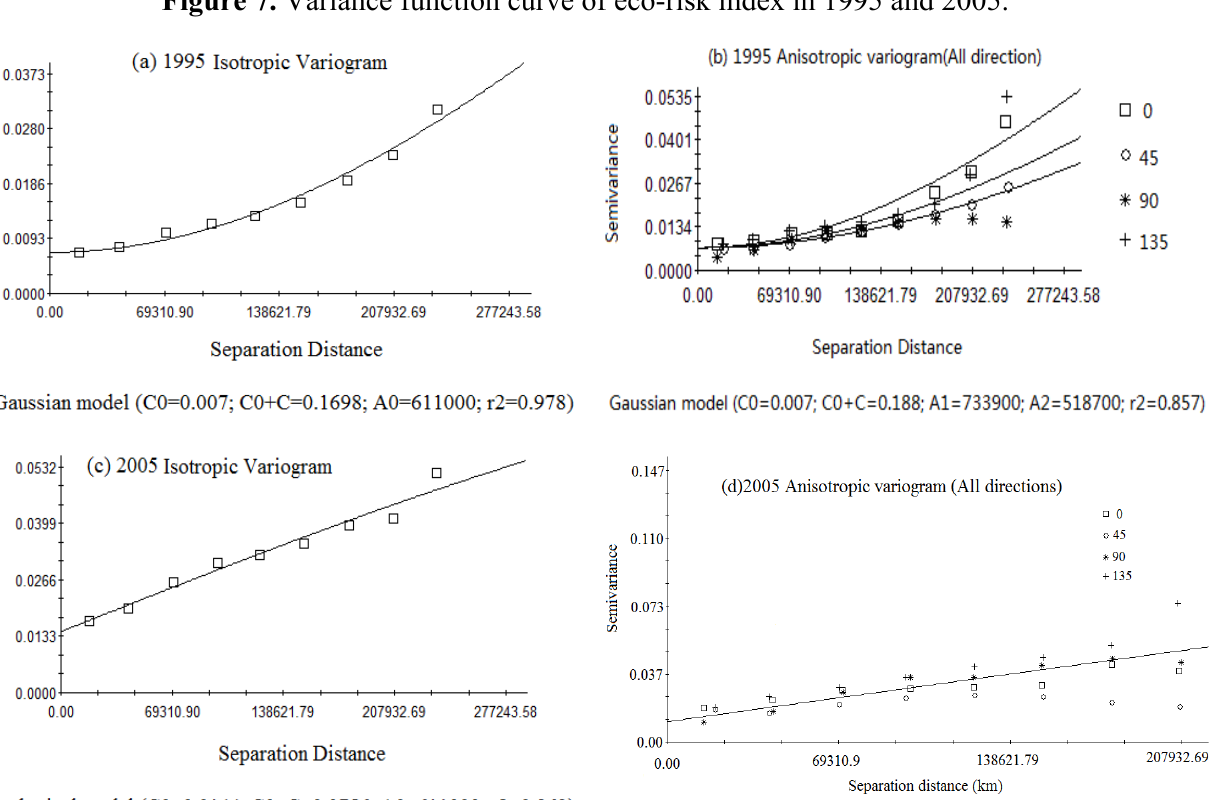
Figure 7. Variance function curve of eco-risk index in 1995 and